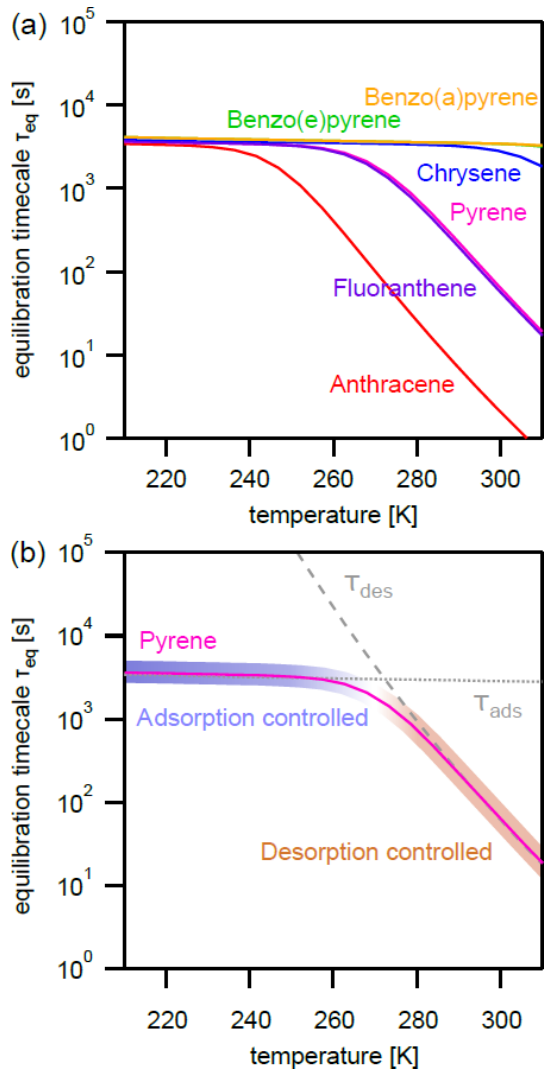
Figure 4. (a) Equilibration timescale τ eq for different PAHs as a function of temperature at a constant particle number concentration ( N p = 1 × 10 3 particlescm − 3 ). (b) Comparison of the equilibration timescale of pyrene to the timescales of adsorption τ ads and desorp- tion τ des , highlighting the transition between adsorption-controlled and desorption-controlled